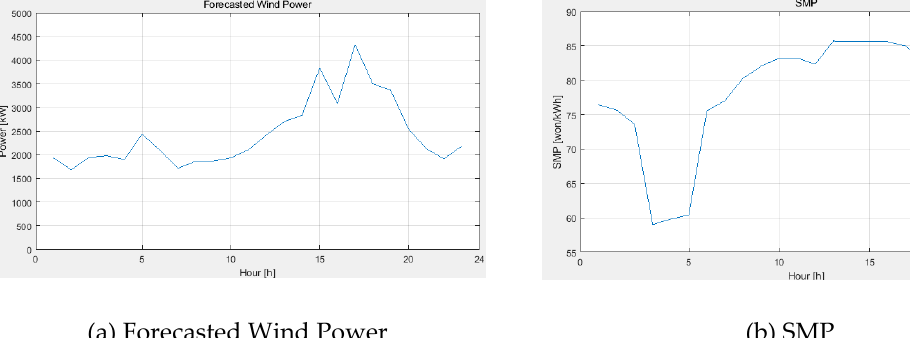
Figure 2. Simulation common input data.